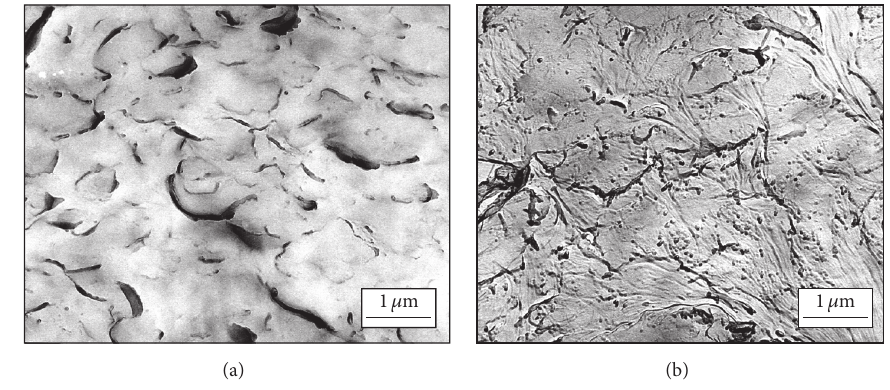
Figure 3: TEM micrographs of the structure of PP-OMMT: (a) the initial one; (b) after ECMAE.